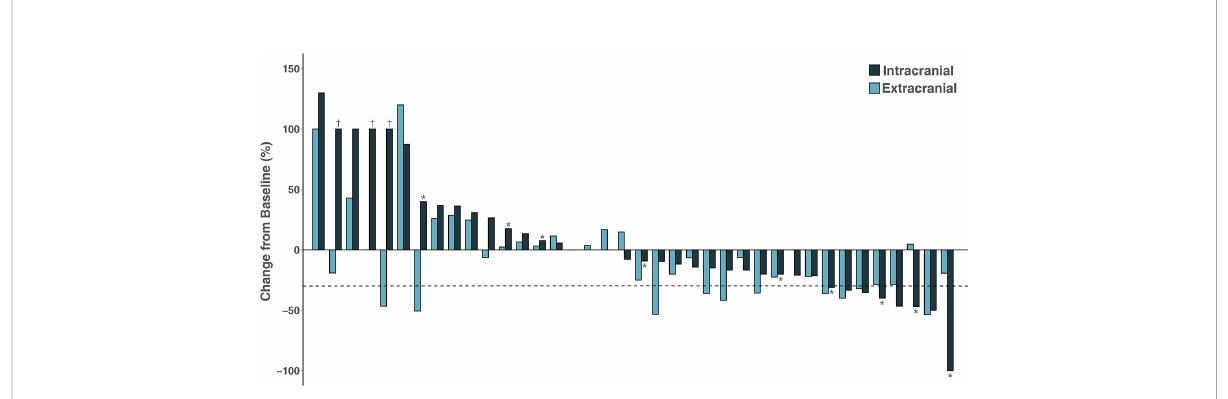
FIGURE 2 Waterfall plot of intracranial and extracranial change patients with measurable intracranial lesions. † Disease progression due to the development of new lesions; *Patients receiving concurrent intracranial radiotherapy.